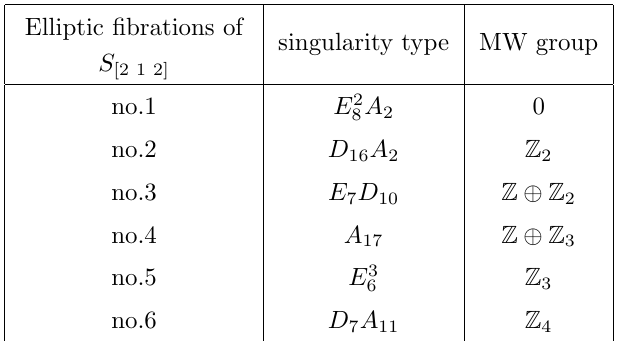
Table 4 . Elliptic (cid:12)brations of the attractive K3 surface S and the Mordell-Weil groups.